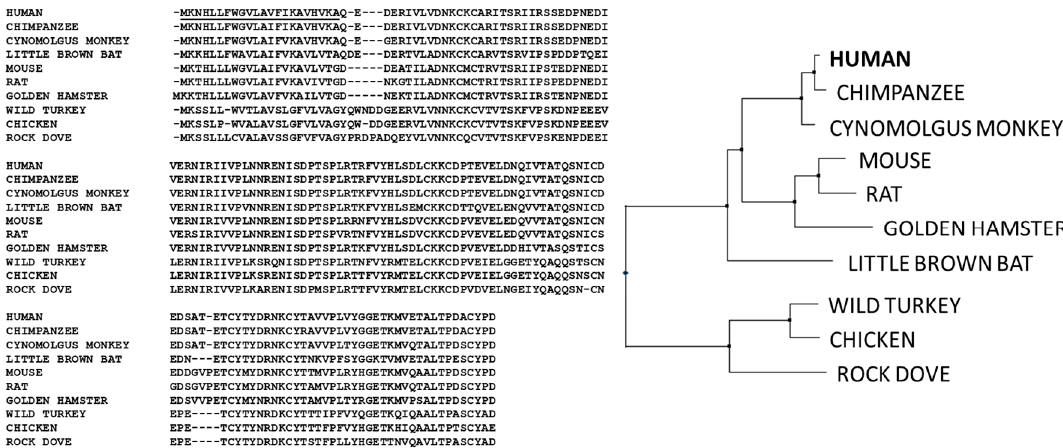
Figure 5. Sequence alignment ( left ) and hierarchical clustering (CLUSTALW, right ) of IgM joining chains (J-chains) showing the high degree of conservation across species from human, primates, rodents, and birds.